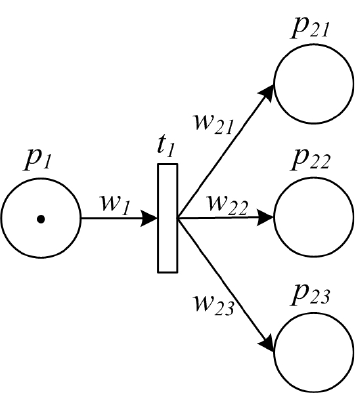
Figure 3. PPN model of split